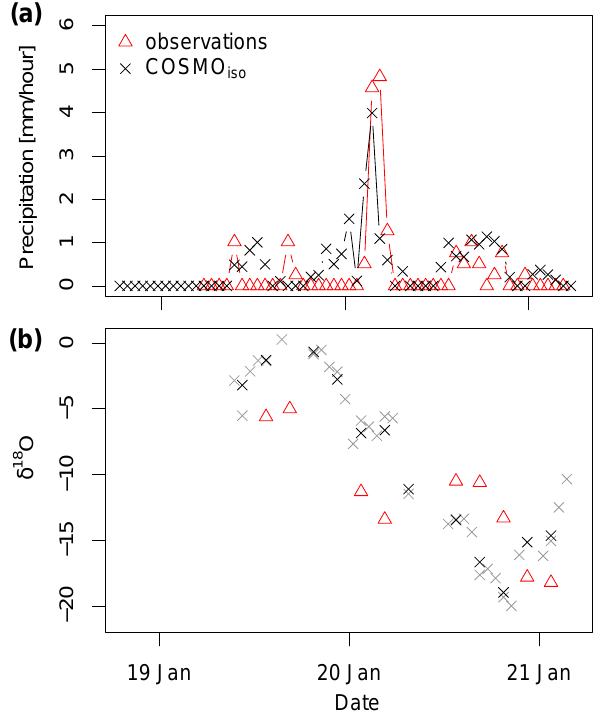
Fig. 6. Time series of hourly precipitation (a) and δ 18 O in precipita- tion, given in ‰ (b) at station AVP (green outer circle in Fig. 5a–c). Precipitation amounts have been obtained from the National Cli- matic Data Center at NOAA. Grey crosses in (b) indicate hourly val- ues, black crosses show three-hourly intensity-weighted averages, corresponding to the observation intervals. COSMO iso δ 18 O data are only shown if the simulated precipitation is larger than 0.1mm per hour.